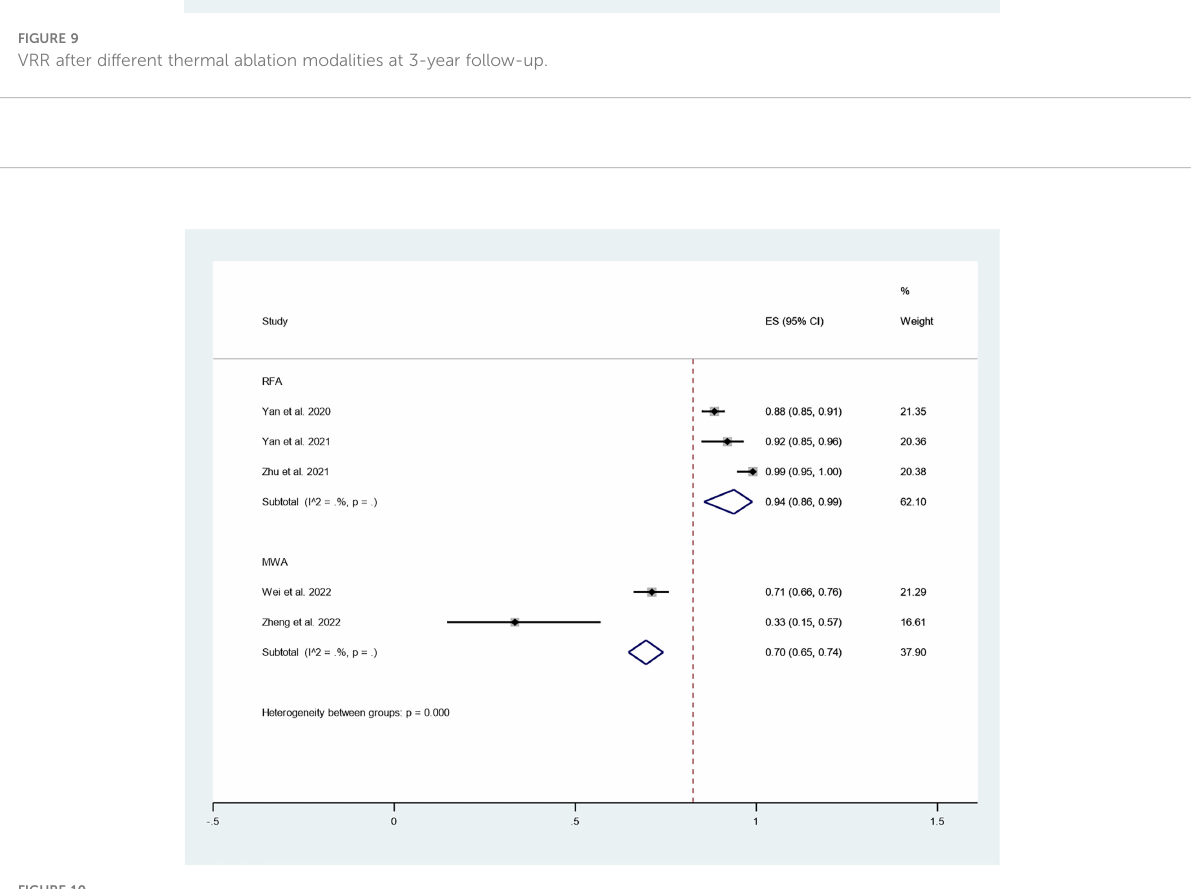
FIGURE 10 CDR after different thermal ablation modalities at 3-year